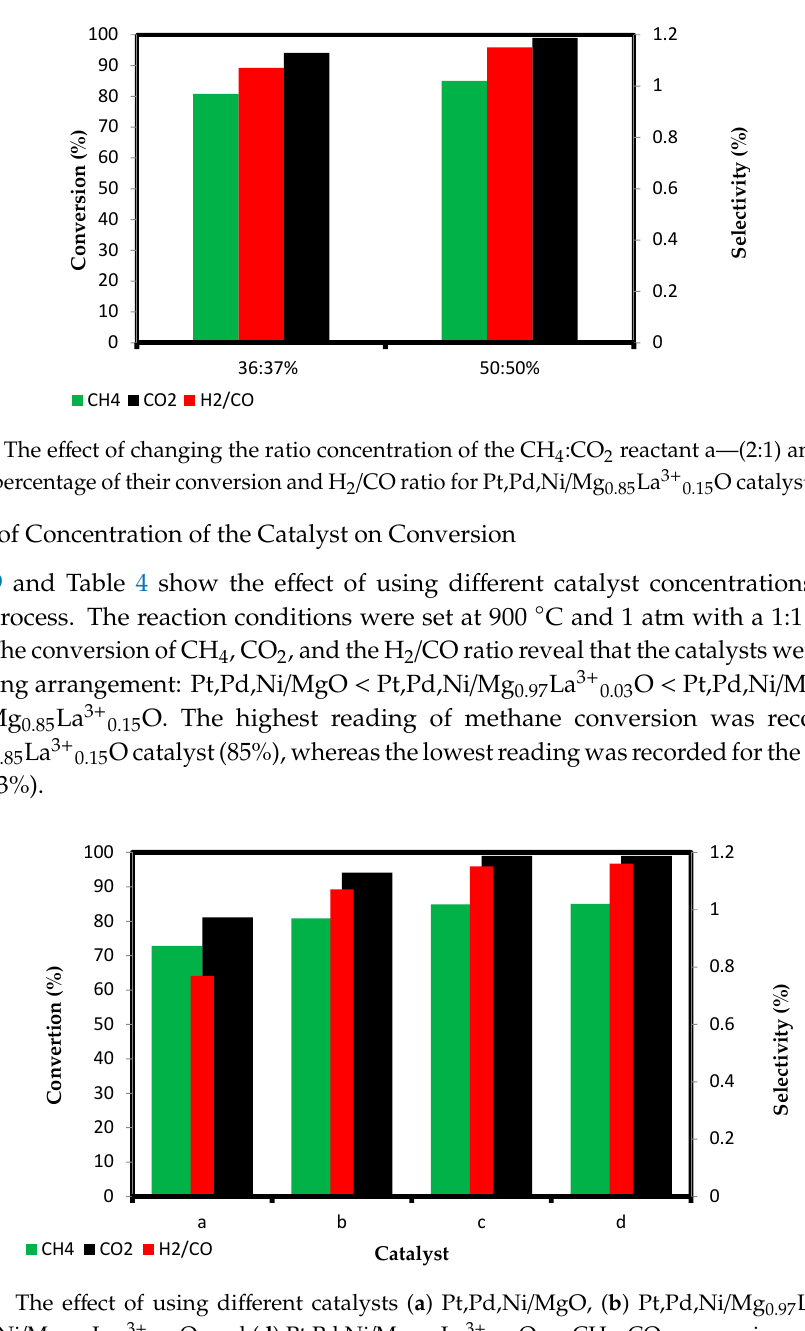
Figure 7. The effect of changing the ratio concentration of the CH 4 :CO 2 reactant a—(2:1) and b—(1:1) over the percentage of their conversion and H 2 /CO ratio for the support-promoter (Mg 1 − x La x O) of the catalyst at 900 °C.